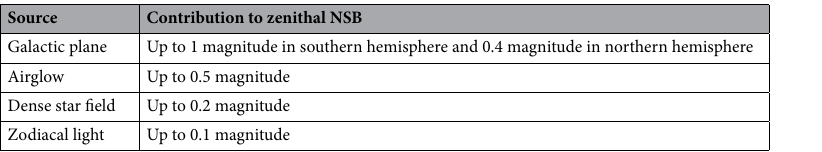
Table 1. Estimation of the contribution of natural light sources to the zenithal